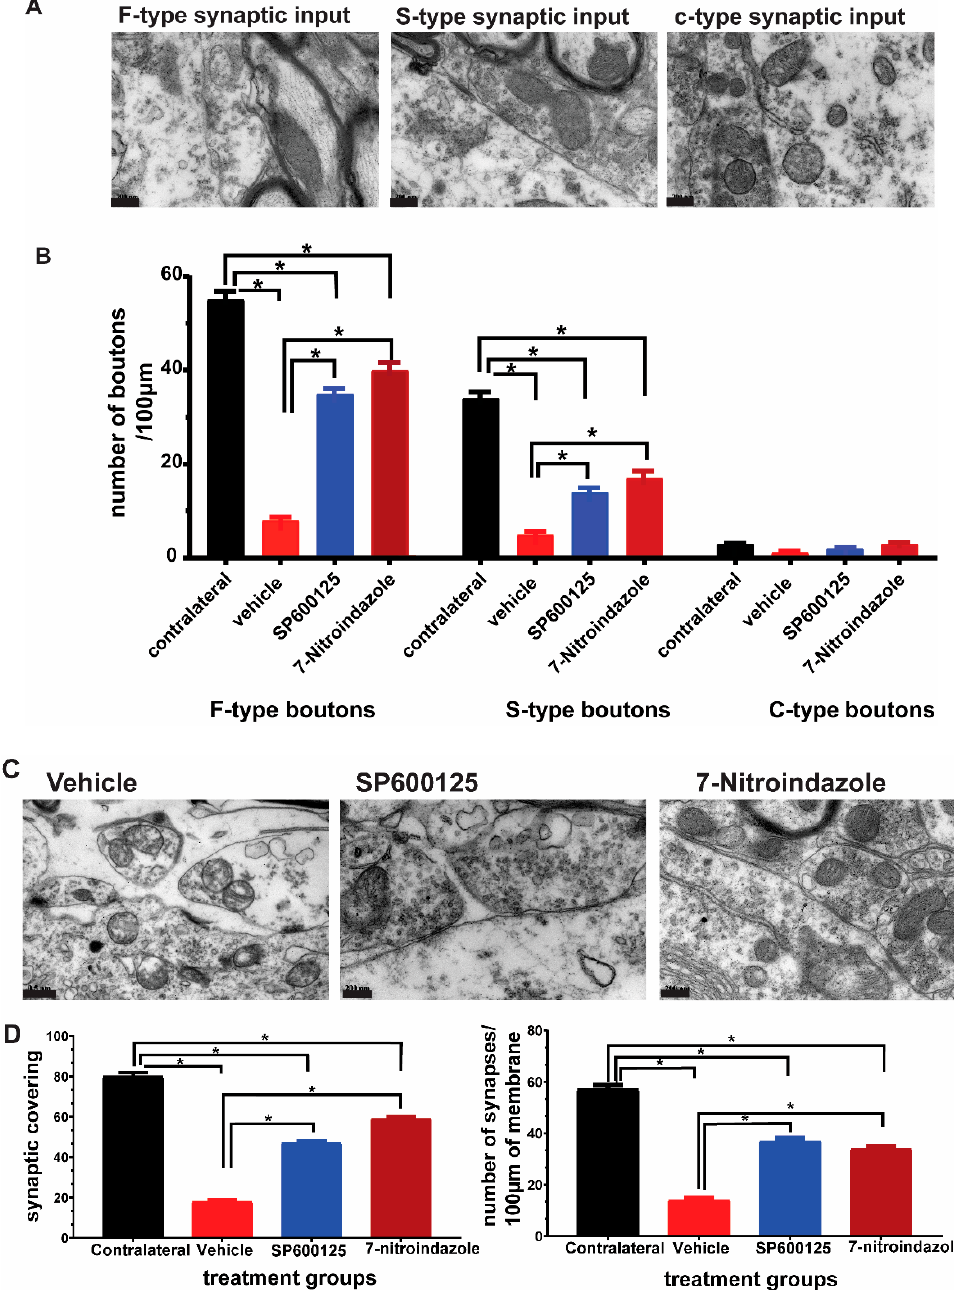
Figure 5. Representative TEM images of the ultrastructure of synapses F-, S- and c-type synapses apposed to α motor neurons. ( A , B ). Types and distribution of synaptic buttons types per 100 μ m on the surface of the vehicle, 7-nitroindazole, and SP600125-treated rats’ motor neurons. Normal refers to the contralateral side without avulsion. Scale bar: 200 nm. ( C ). Ultrastructure of synapses apposed to α motor neurons showing near normal input apposition on the surface of 7-NI (7-nitroindazole) α motor neuron, near normal and partial retraction (SP600125-treated) and retracted terminal intermingled with an astrocyte projection in the vehicle (avulsion only) rats. Motor neuron; ( C ), SP600125-treated rat shows retracted terminal intermingled with an astrocyte projection following ventral root avulsion. ( D ). Distribution of synaptic buttons per 100 μ m, as well as synaptic covering on the surface of the vehicle, 7-nitroindazole, and SP600125-treated rats’ motor neurons. Normal refers to the contralateral side without avulsion used as control. The colorized part is the α motor neurons. Values are expressed as the Mean ± SD. Comparisons between groups were by One-way ANOVA whereby * denotes p ≤ 0.05.